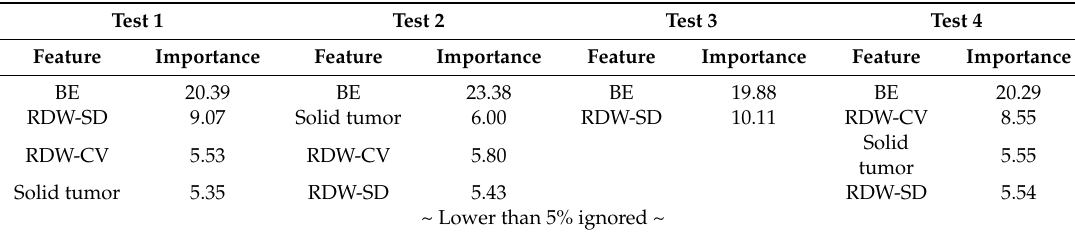
Table 4. Feature importance of 28 d mortality prediction by RF